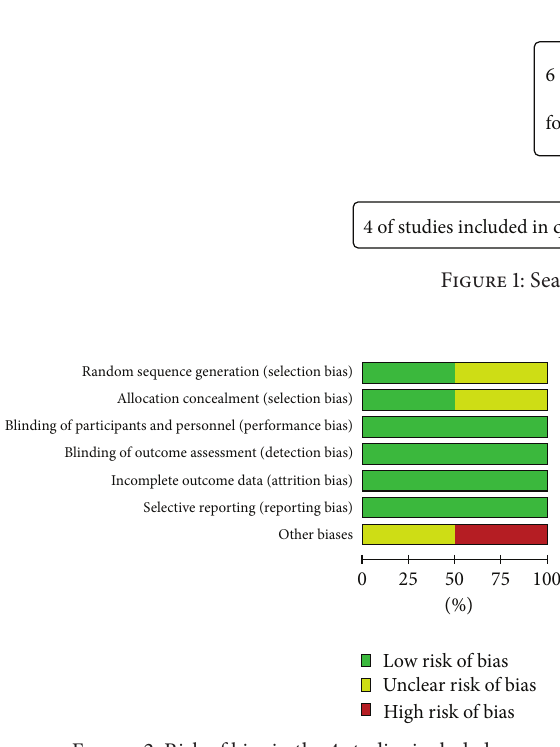
Figure 2: Risk of bias in the 4 studies included.